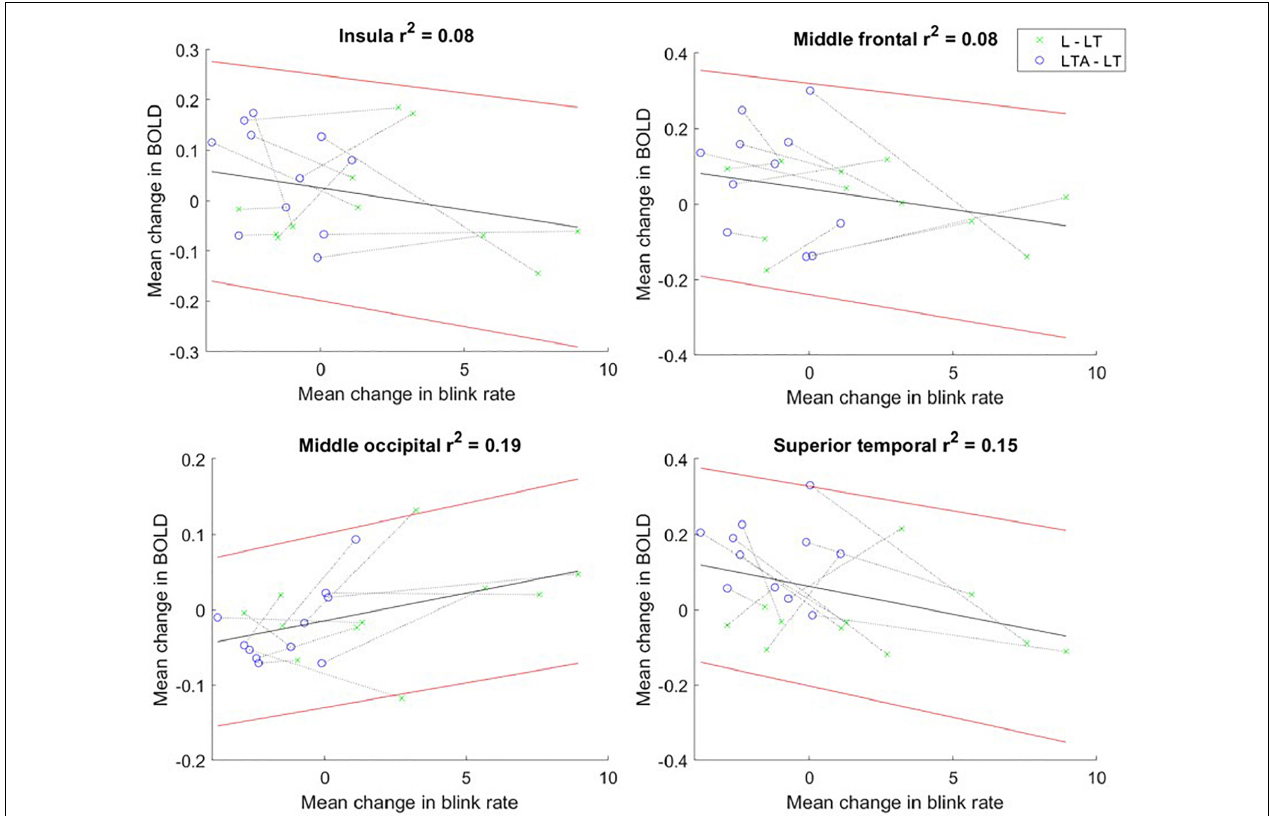
FIGURE 7 | Mean change in BOLD fMRI signal vs. mean change in blink rate for “L – LT” (green) and “LTA – LT” (blue) task contrasts for the insula, and regions of interest in the middle frontal, middle occipital and superior temporal gyri. The dotted line connects the data points for each participant. The linear regression line is shown in black, with the 95% confidence interval for the regression line shown in red. BOLD, blood oxygenation level dependent; L, left turns; LT, left turns with oncoming traffic; LTA, left turns with oncoming traffic and auditory